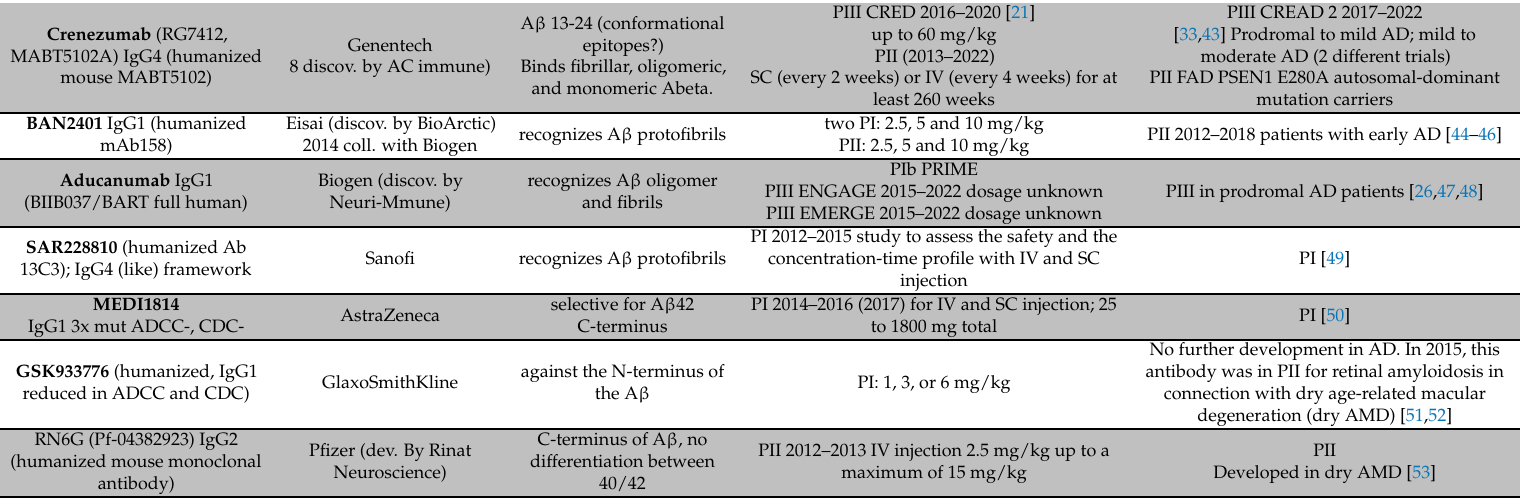
two PI: 2.5, 5 and 10 mg/kg PII: 2.5, 5 and 10